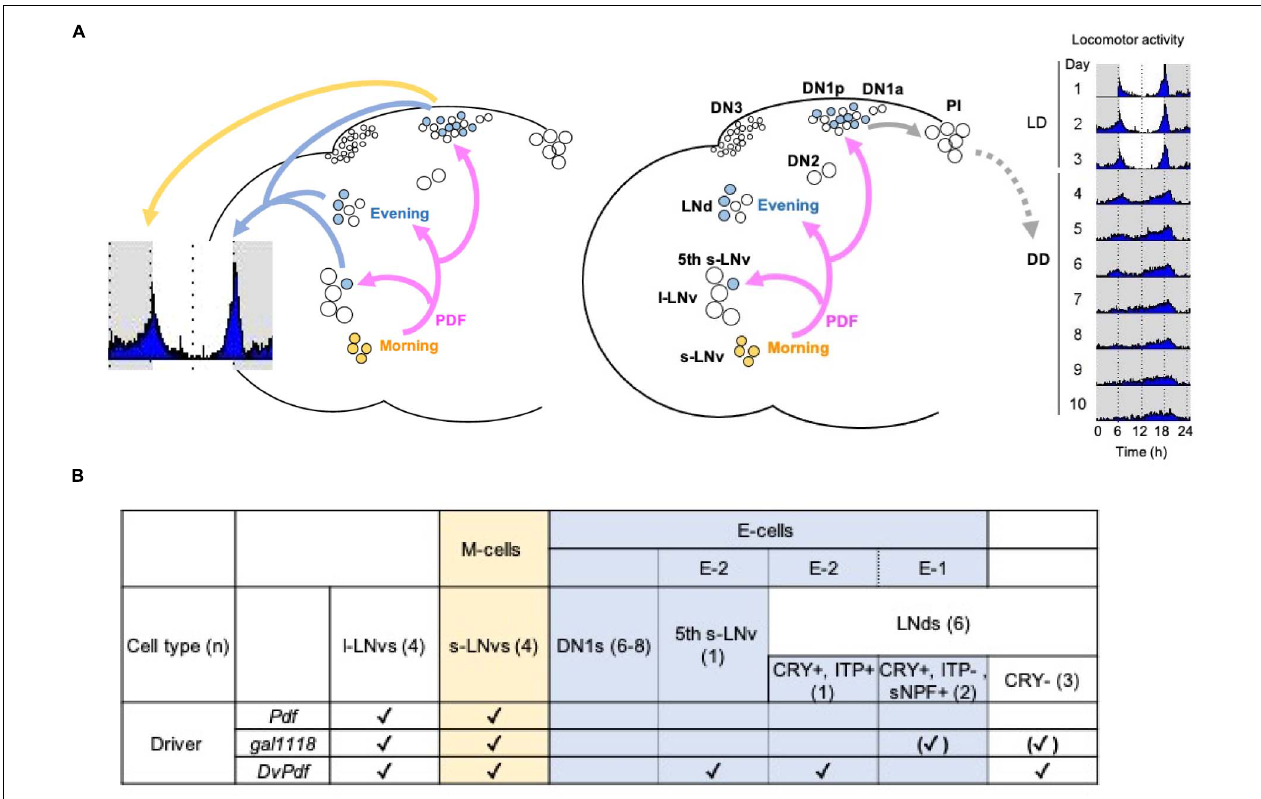
FIGURE 1 | Current model of the circadian pacemaker circuit organization in Drosophila melanogaster. (A) Four PDF-positive s-LNvs constitute the Morning (M)-cells and the Evening (E)-cells consist of the 5th s-LNv, three CRY-positive LNds and 6–8 DN1ps. Left, in LD and constant temperature, the M-cells control the morning activity peak through PDF signaling onto the DN1ps. The E-cells drive the evening activity peak. In certain environmental conditions, the DN1ps are able to drive both morning and evening peaks. Right, in DD and constant temperature, the M-cells determine the pace of the locomotor rhythms via PDF signaling to the E-cells. However, the coupling between the M- and E-cells are within a limited temporal range. Among the E-cells, CRY- and sNPF-positive, ITP-negative 2 LNds [E-1, see (B) ] are strongly coupled to the oscillation of the M-cells, whereas the 5th s-LNv and one ITP-positive LNd (E-2) are weakly coupled. One of the locomotor output circuits is found downstream of the DN1ps, which are connected to neuroendocrine cells in the pars intercerebralis (PI). (B) The identity of the M- and E-cells and the expression patterns of the GAL4 drivers used in this study. Pdf-GAL4 is expressed in the l- and s- LNvs (Renn et al., 1999). gal1118 is expressed in the l- and s-LNvs and weakly in the LNds. However, expression in the LNds is detectable only in the flies homozygous for gal1118 (Blanchardon et al., 2001). DvPdf-GAL4 is expressed in all the LNvs and one CRY-positive, ITP-positive LNd and three CRY-negative LNds (Bahn et al., 2009; Schubert et al., 2018). (n) indicates the number of cells per